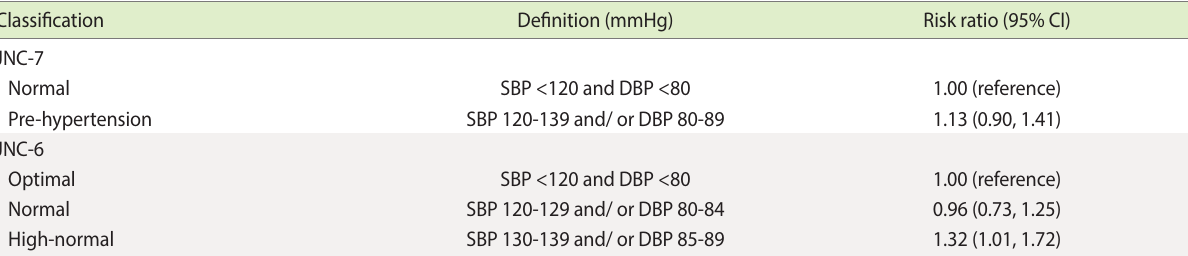
Table 2. Risk of incident diabetes over 5 years in the adult population of Shahroud using inverse probability treatment weighting methods in a log binomial regression